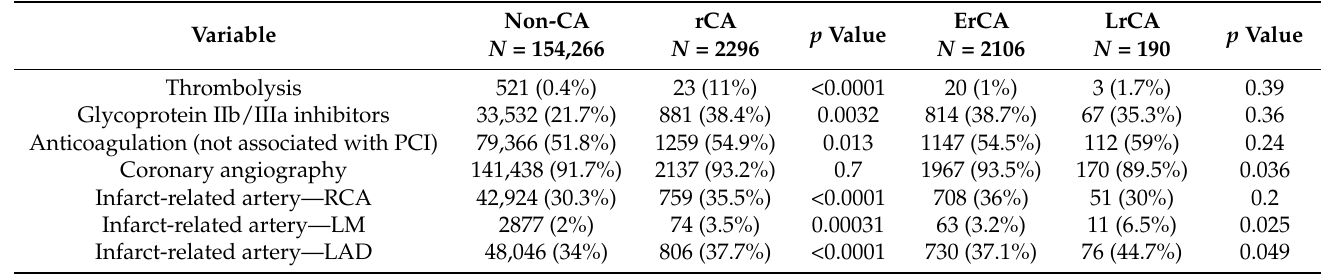
Table 2. In-hospital treatment and procedures of patients without cardiac arrest and with ErCA and LrCA after acute myocardial infarction (only patients who were discharged after index